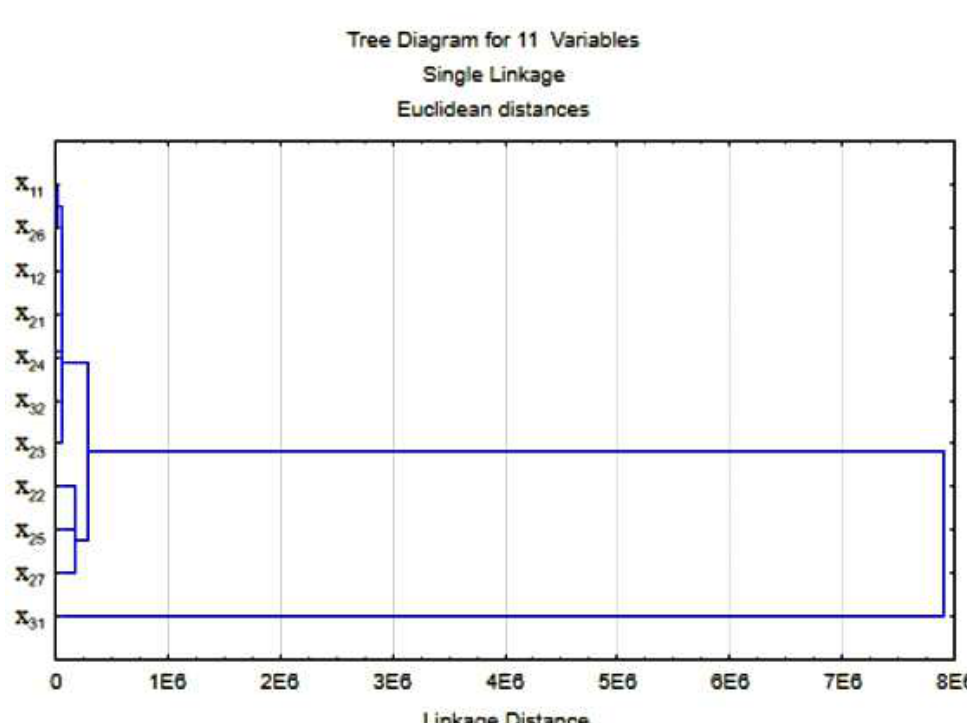
Figure 6. Dendrogram to identify the activators of the banking digitalization level in Ukraine in the context of the COVID-19 pandemic based on CSR principles for